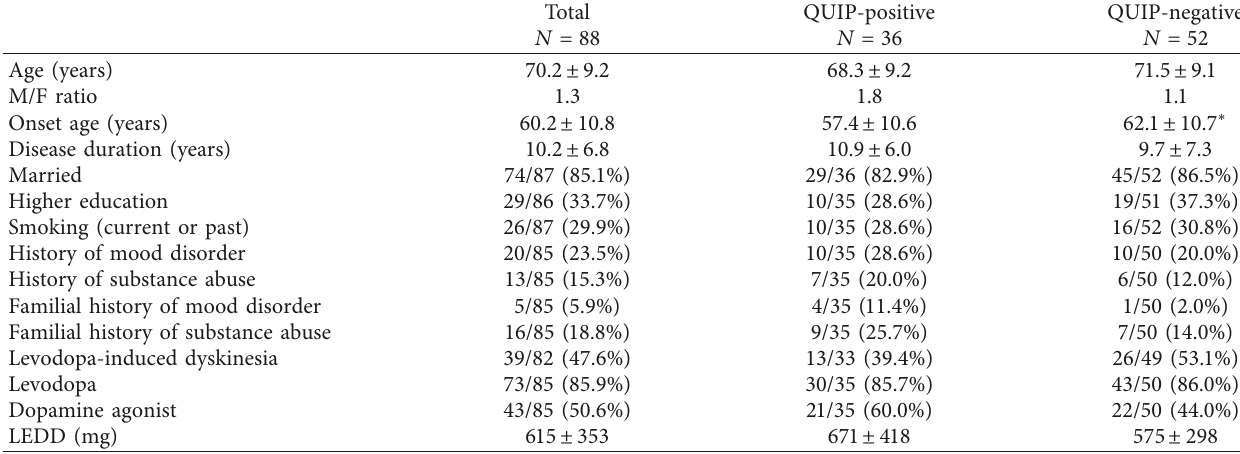
Table 1: Clinical characteristics of complete study population, QUIP-positive, and QUIP-negative